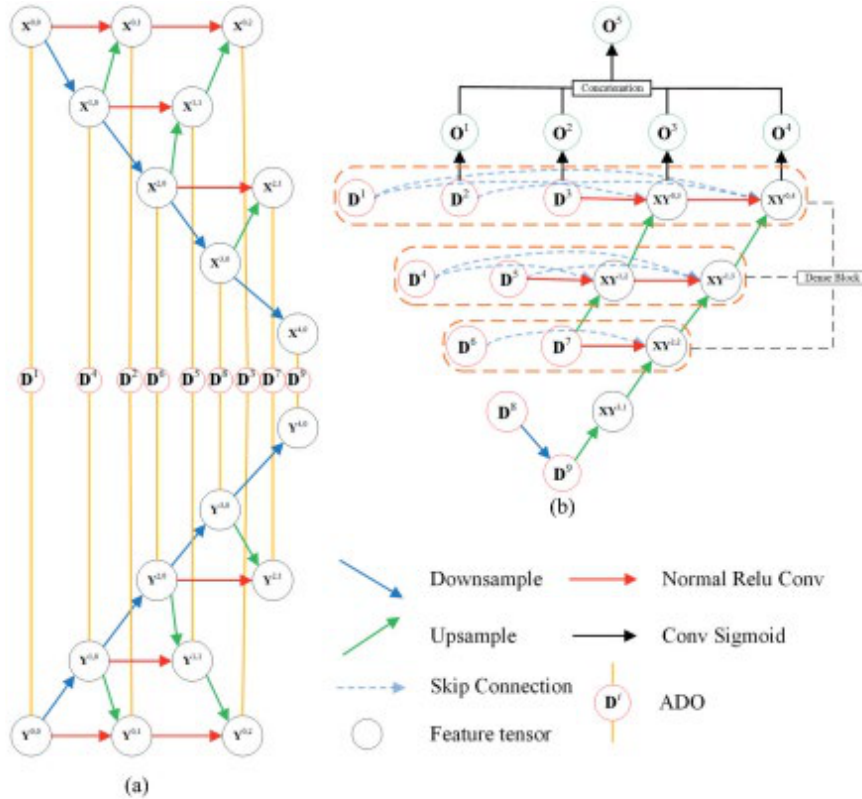
Figure 2. Segmentation procedure employing NtNt framework.